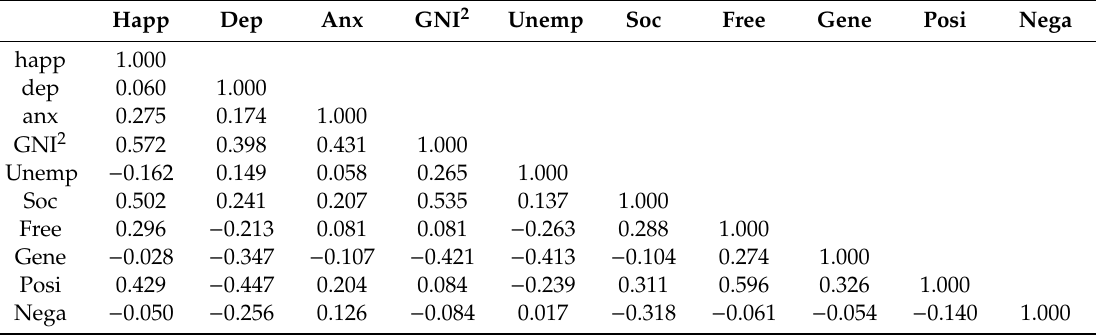
Table A3. The correlation matrix among variables in middle-income countries.